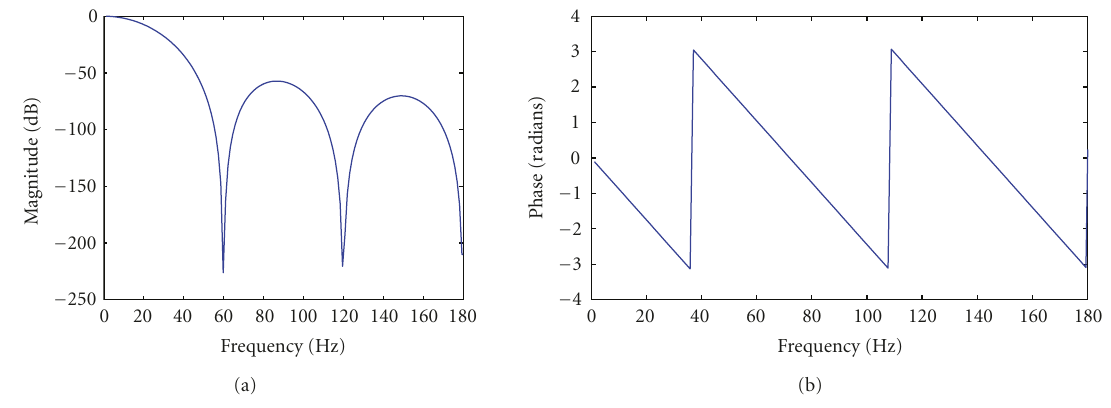
Figure 1: Magnitude and phase of lowpass